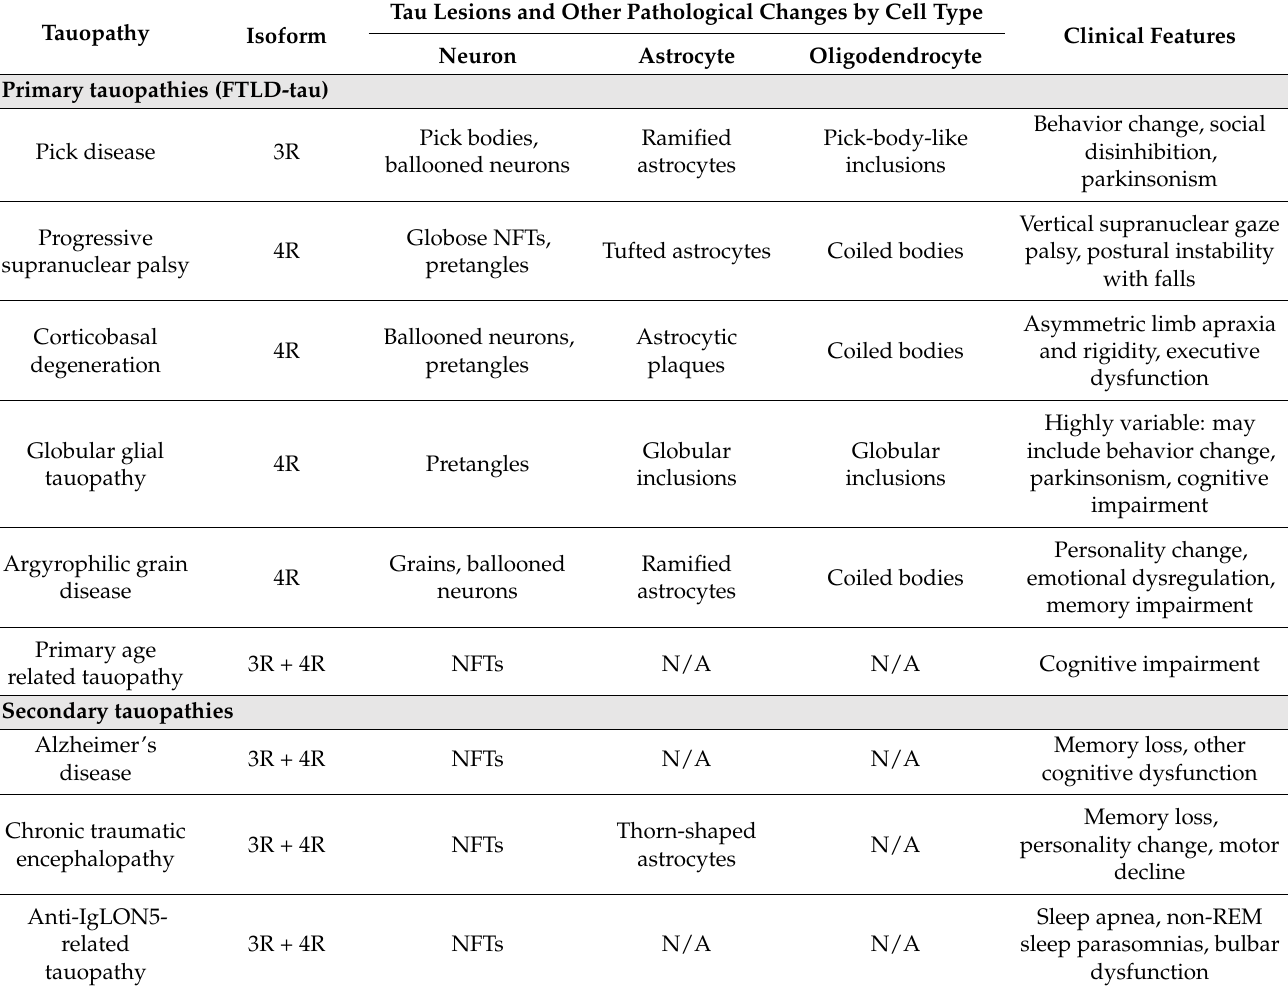
Table 2. Clinical features and tau lesional characteristics of selected